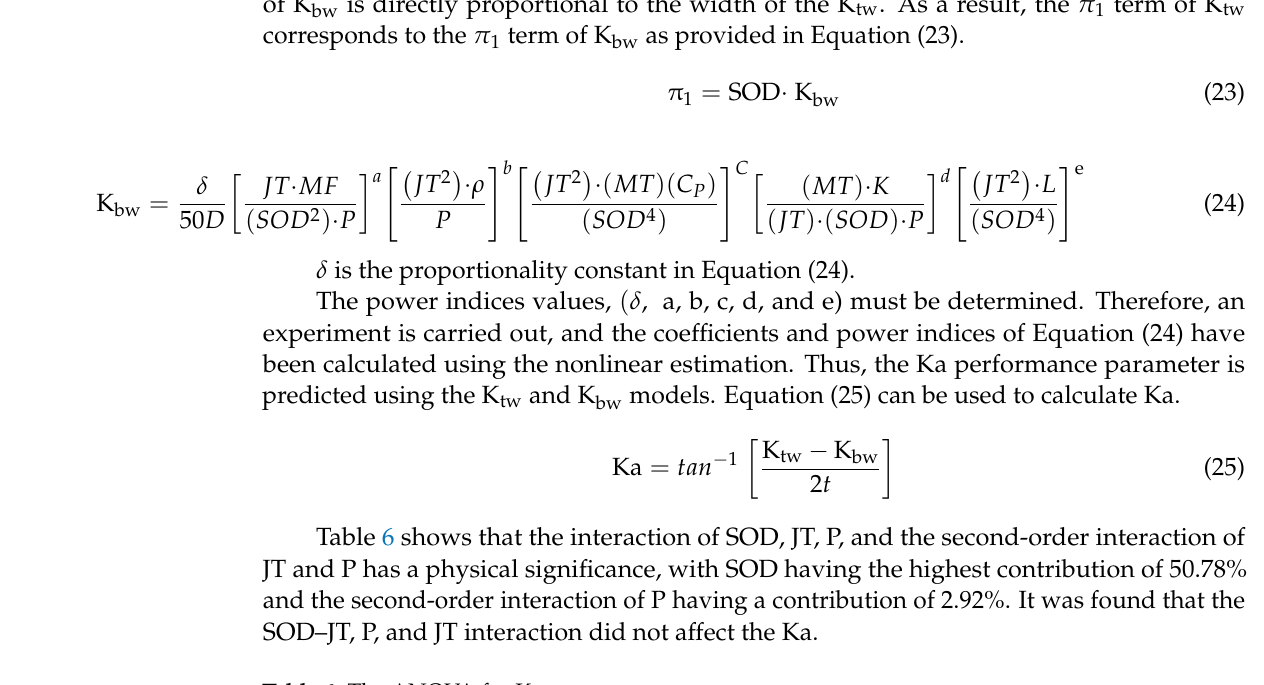
Table 6. The ANOVA for